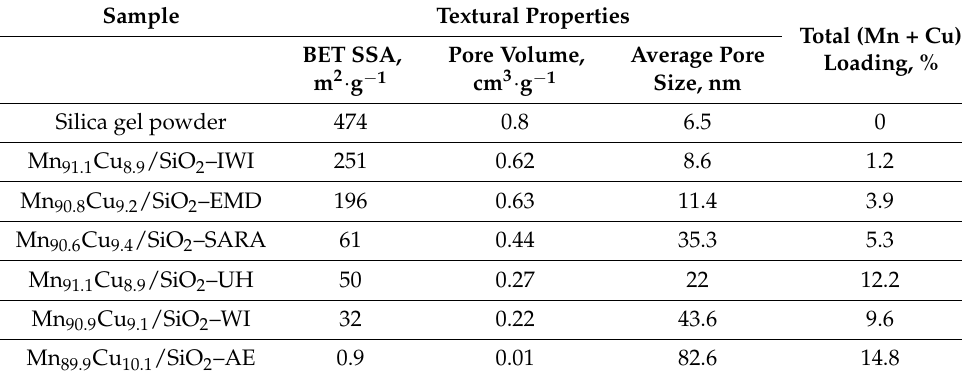
Table 2. Textural properties and the total metal loading of the Mn–Cu oxide catalyst supported by the silica gel powder (based on the N 2 adsorption analysis). Sample Textural